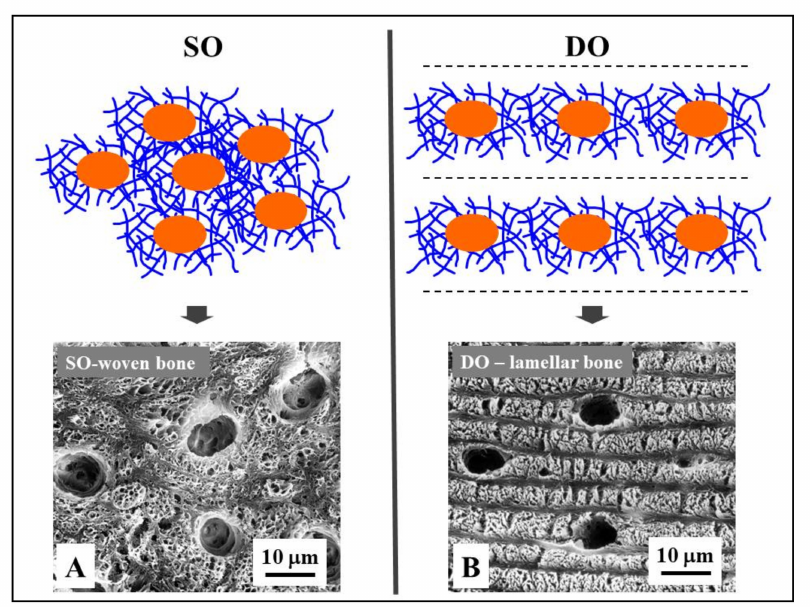
Figure 5. Osteocyte arrangements in static and dynamic osteogenesis ( top ): Osteocytes (orange) are always found within a pericellular loose collagen texture (blue) in both SO (osteocytes arranged in group) and DO (osteocytes recruited on a plane). Depending on the cell arrangement, woven bone texture forms in SO, while lamellar bone forms in DO. ( bottom ) SEM micrographs ( A , B ) of osteocyte lacunae in SO ( right ) and DO ( left